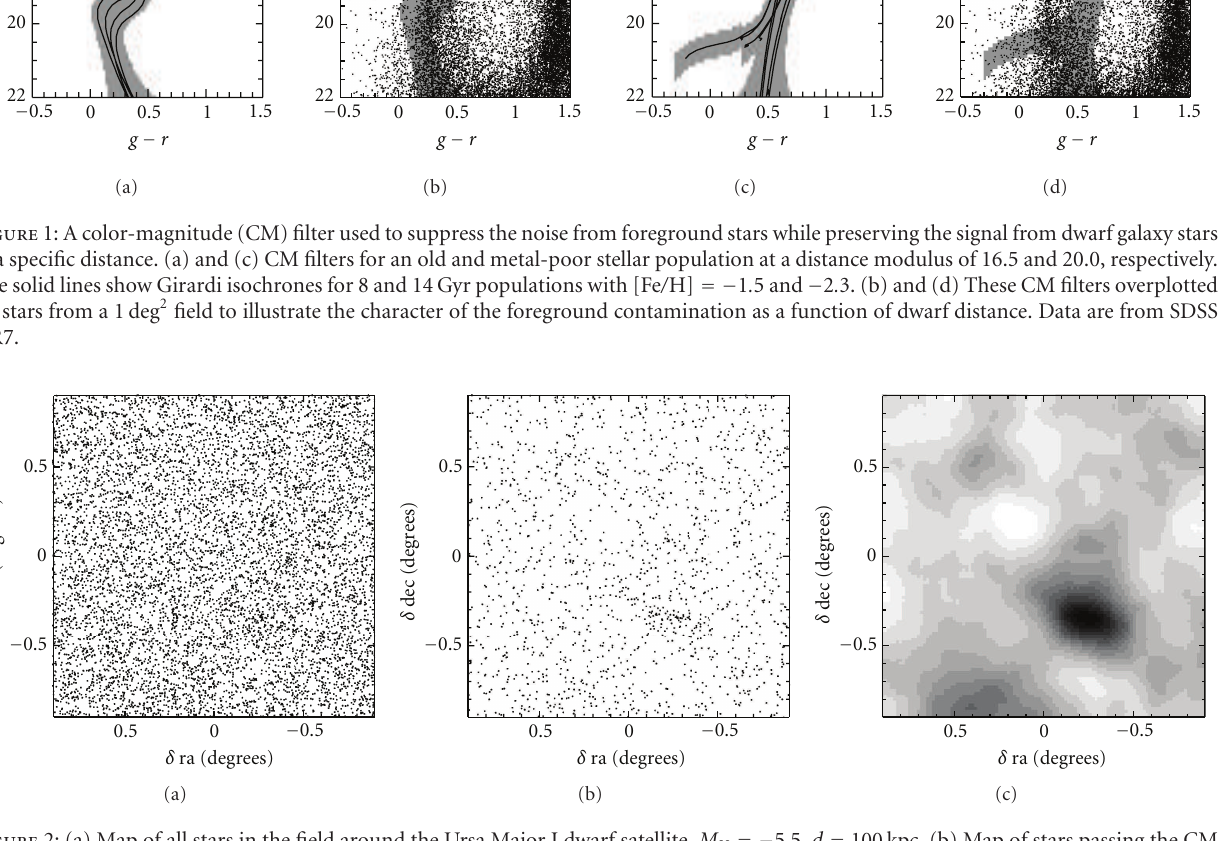
Figure 2: (a) Map of all stars in the field around the Ursa Major I dwarf satellite, M V = − 5 . 5, d = 100 kpc. (b) Map of stars passing the CM filter projected to m − M = 20 . 0 shown in Figure 1(c). (c) Spatially smoothed number density map of the stars in (b). The Ursa Major I dwarf galaxy has a μ V ,0 of only 27.5mag arcsec 2 [63]. Data are from SDSS